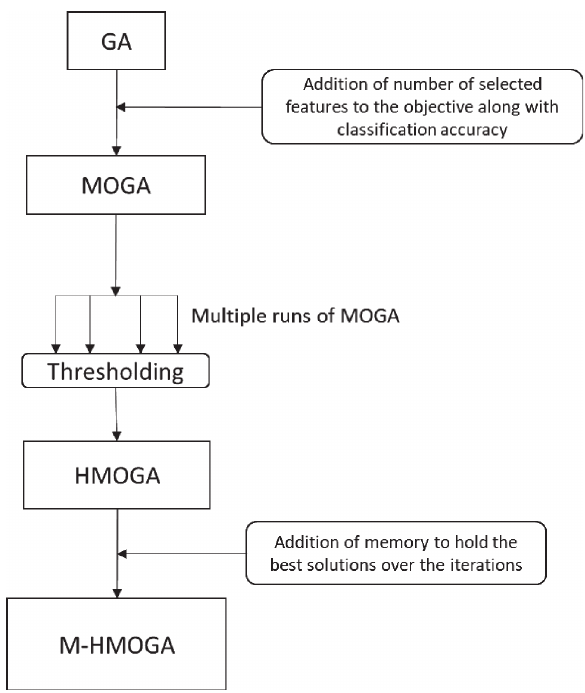
Figure 1: Flow Diagram of Our Proposed M-HMOGA Methodology Evolved Initially from GA.